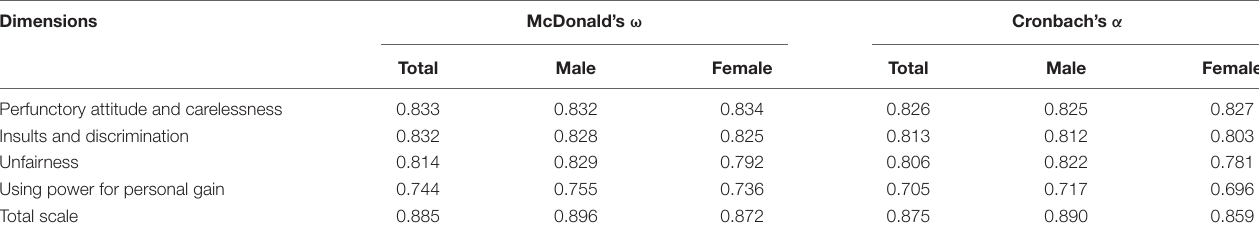
TABLE 6 | Composite reliability and consistency reliability of the unethical professional behavior tendencies scale.